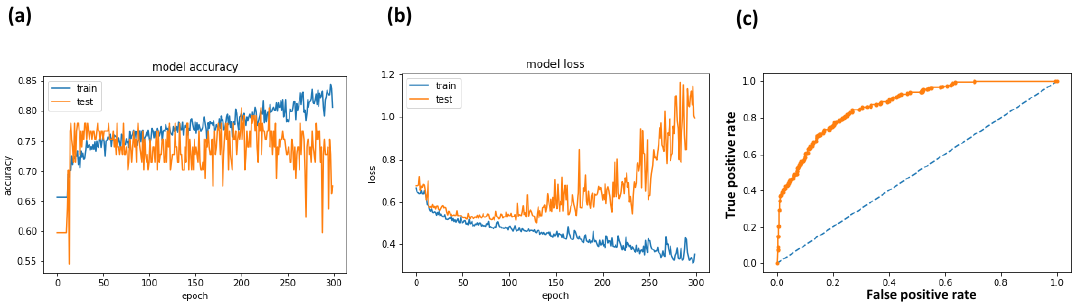
Figure 8. LSTM results (training dataset = 90%, testing dataset = 10%): ( a ) Model accuracy versus epochs; ( b ) model loss versus epochs; ( c ) ROC curve.